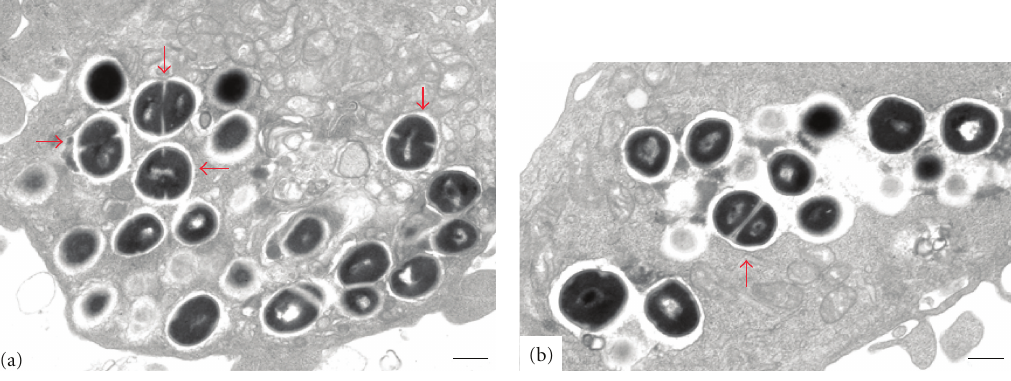
Figure 10: Electron microscopy of S. aureus USA300 infected GFP-WIPI-1 expressing U2OS cells. GFP-WIPI-1 U2OS cells were infected with S. aureus USA300 in DMEM/FCS followed by conventional electron microscopy. Either single S. aureus USA300 cells were found to reside within a vesicle (a), or multiple cells were found in enlarged vesicles (b). Red arrows indicate dividing Staphylococci. Scale bars: